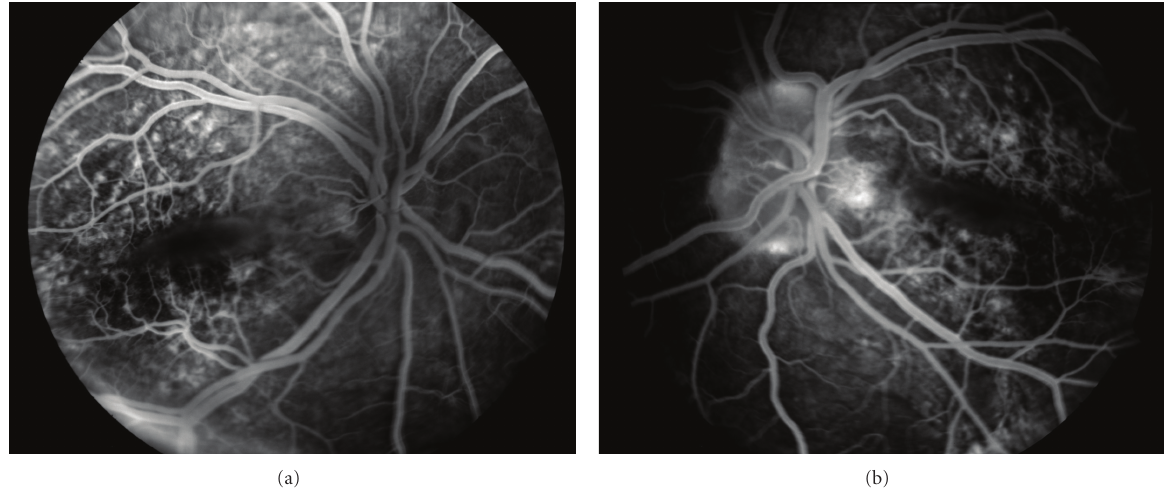
Figure 3: Fluorescein angiographies of case 2 show mottled hyperfluorescence due to pigment epithelial changes and mild hypofluorescence in the fold area ((a): right, (b):